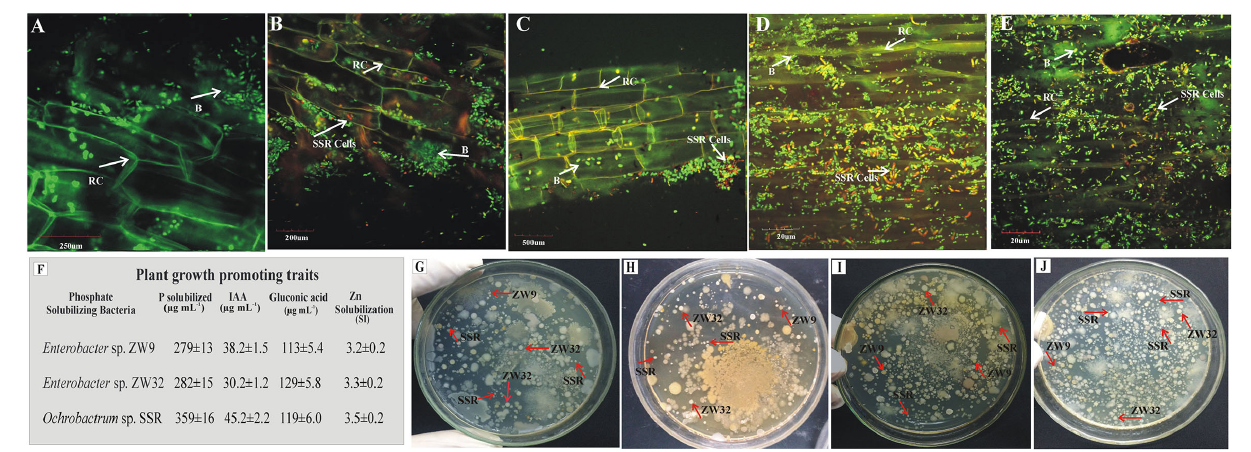
FIGURE 7 | Re-isolation and detection of inoculated P-solubilizing bacteria. The CLSM of wheat roots at 35 days post inoculation of P-solubilizing bacteria in the pot experiment under net house conditions. The FLUOS-labeled oligonucleotide probes showed green fluorescent signals for total bacterial population and Cy3-labeled oligonucleotide probes showed red fluorescent signals for inoculated Ochrobactrum sp. SSR. (A) Control treatments without inoculation and from the PSB inoculated pots with carrier materials (B) Biochar, (C) CM, (D) FM, and (E) HA after hybridizing with fluorescently labeled probes. The plant growth promoting traits of re-isolated PSB strains for their confirmation in comparison to pure PSB (F) . The plates depicting the re-isolated colonies of SSR, ZW32, and ZW9 from BC (G) , CM (H) , FM (I) and HA (J) in inoculated treatments. Enterobacter spp. ZW9, ZW32, Ochrobactrum sp. SSR. B, bacteria; RC, root